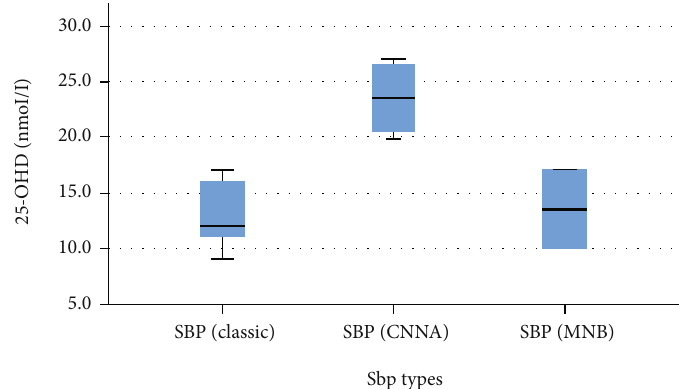
Figure 3: Comparison of 25-OHD levels in di ff erent SBP categories (A fifi , Hussein, and Rizk,